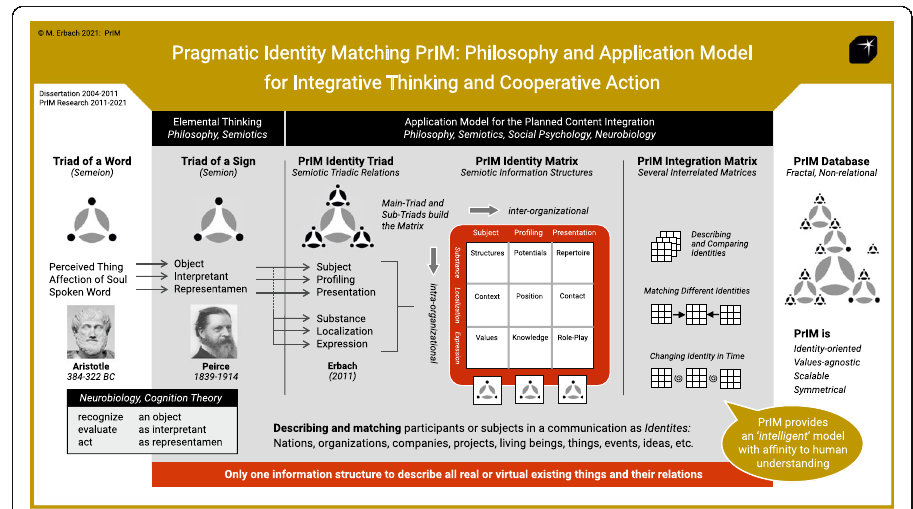
Fig. 2 Pragmatic Identity Matching (PrIM) providing a holistic framework for integrative thinking and cooperative